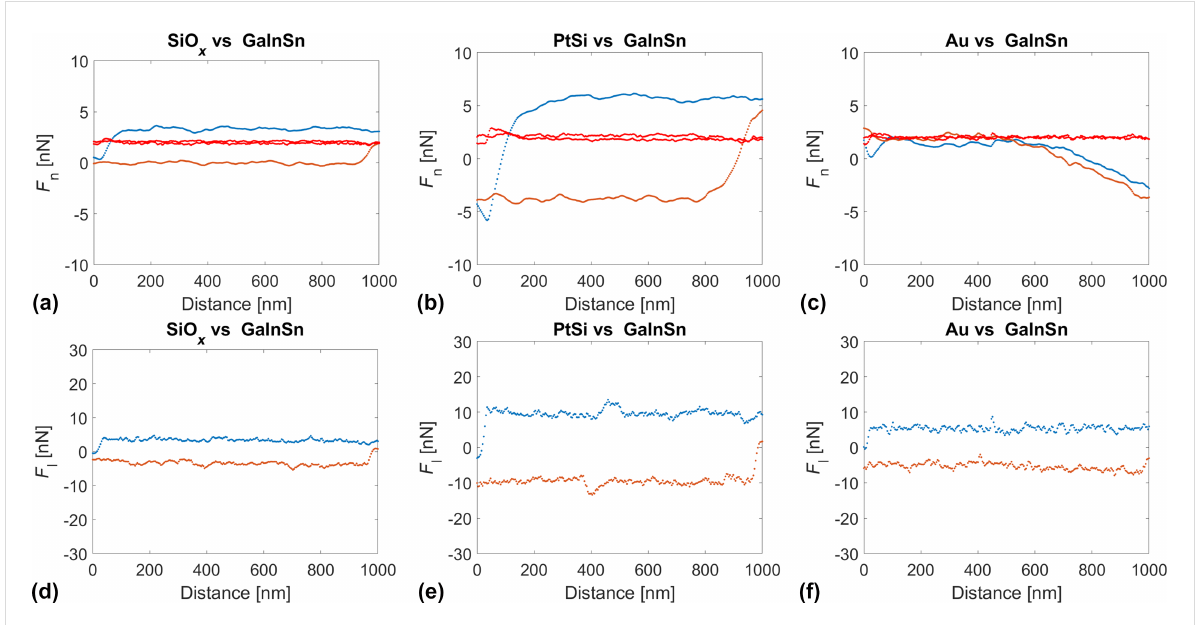
Figure 3: Typical (a–c) F n - and (d–f) F l -traces recorded in contact AFM mode on the surface of the eutectic Ga–In–Sn melt with (a, d) a SiO x tip, (b, e) a PtSi tip, and (c, f) an Au tip.